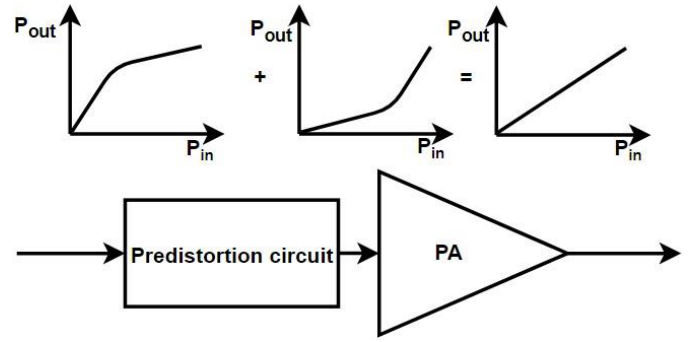
Figure 8. Predistortion linearization conceptual diagram.